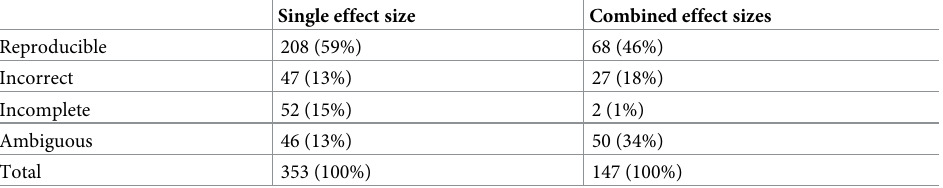
Table 1. Reproducibility frequencies separated by primary study effect sizes consisting of one or multiple com- bined effect